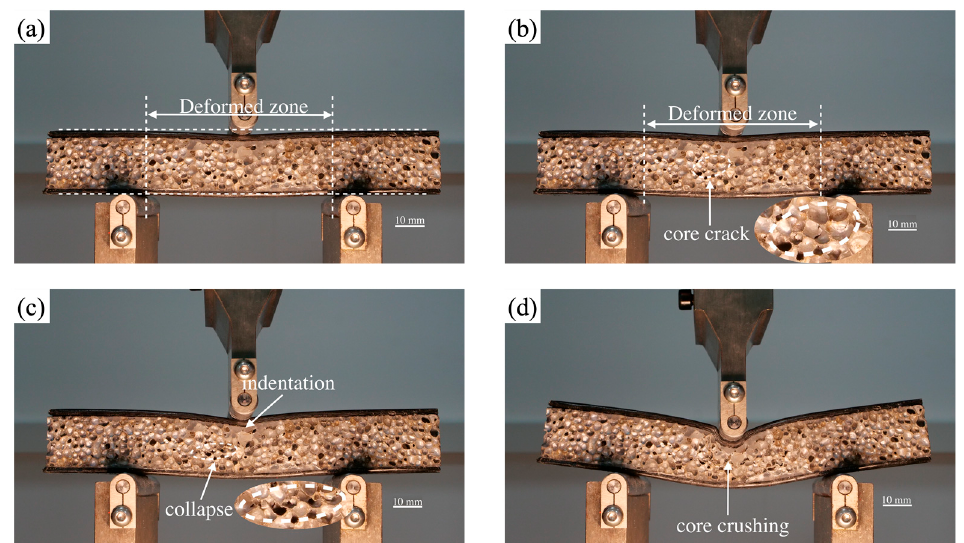
Figure 8. Deformation process of #20-0.37 in three-point bending: ( a ) elastic deformation; ( b ) crack in bubble; ( c ) bubble collapse; ( d ) collapse at loading point. bubble; ( c ) bubble collapse; ( d ) collapse at loading